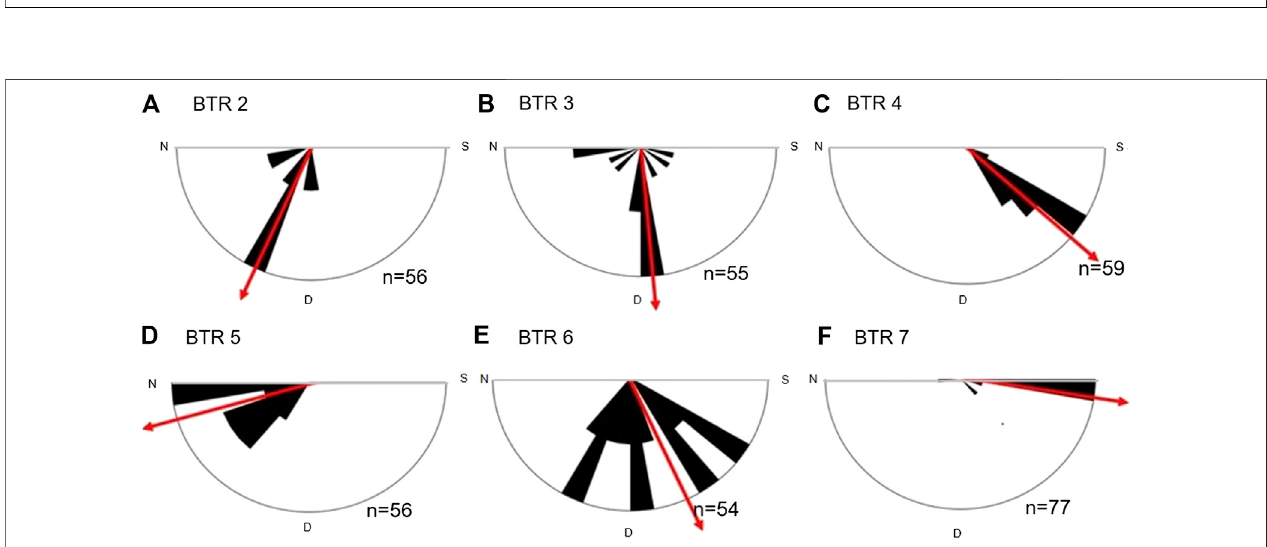
FIGURE7| Rosediagramsofverticalslicesof (A) BTR2; (B) BTR3; (C) BTR4; (D) BTR5; (E) BTR6;and (F) BTR7specimensthatwereusedin μ CTimaging.These diagramsshowthedistributionoftheinclinationporesorientation.VerticalaxisrepresentsUp-DowndirectionwhilehorizontalaxisrepresentsNorth-Southdirection.Red arrows indicate the inclination of the preferred pore